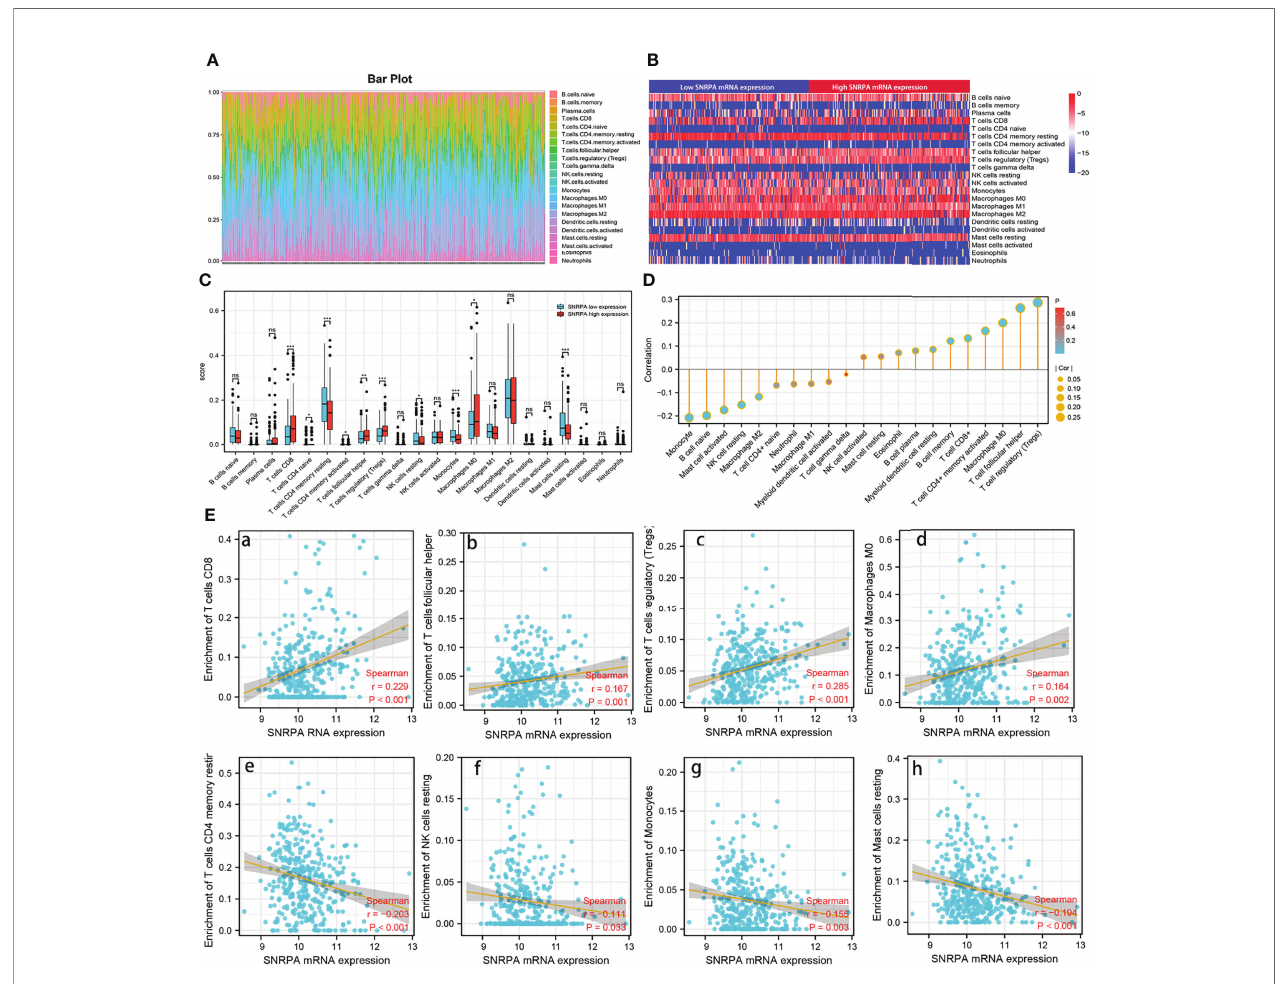
FIGURE 8 | Association analysis of SNRPA mRNA expression and immune in fi ltration. (A) Estimation offractions of immune cells of each tissue, where different colors represented different immune cells. (B) The heatmap showing the difference in immune cells in fi ltration between the high and low SNRPA expression group. (C) The comparison of estimated fractions of 22 immune cells between the high and low SNRPA expression group. (D) The correlation between SNRPA expression and 22 immune cells in HCC using ssGSEA with Spearman r analysis. (E) The correlation of SNRPA mRNA expression with immune in fi ltration level of (a) T cells CD8, (b) T cells follicular helper, (c) T cells regulatory, (d) Macrophages M0, (e) T cells CD4 memory restir, (f) NK cells resting, (g) Monocytes, (h) Mast cells resting. ns, no statistically signi fi